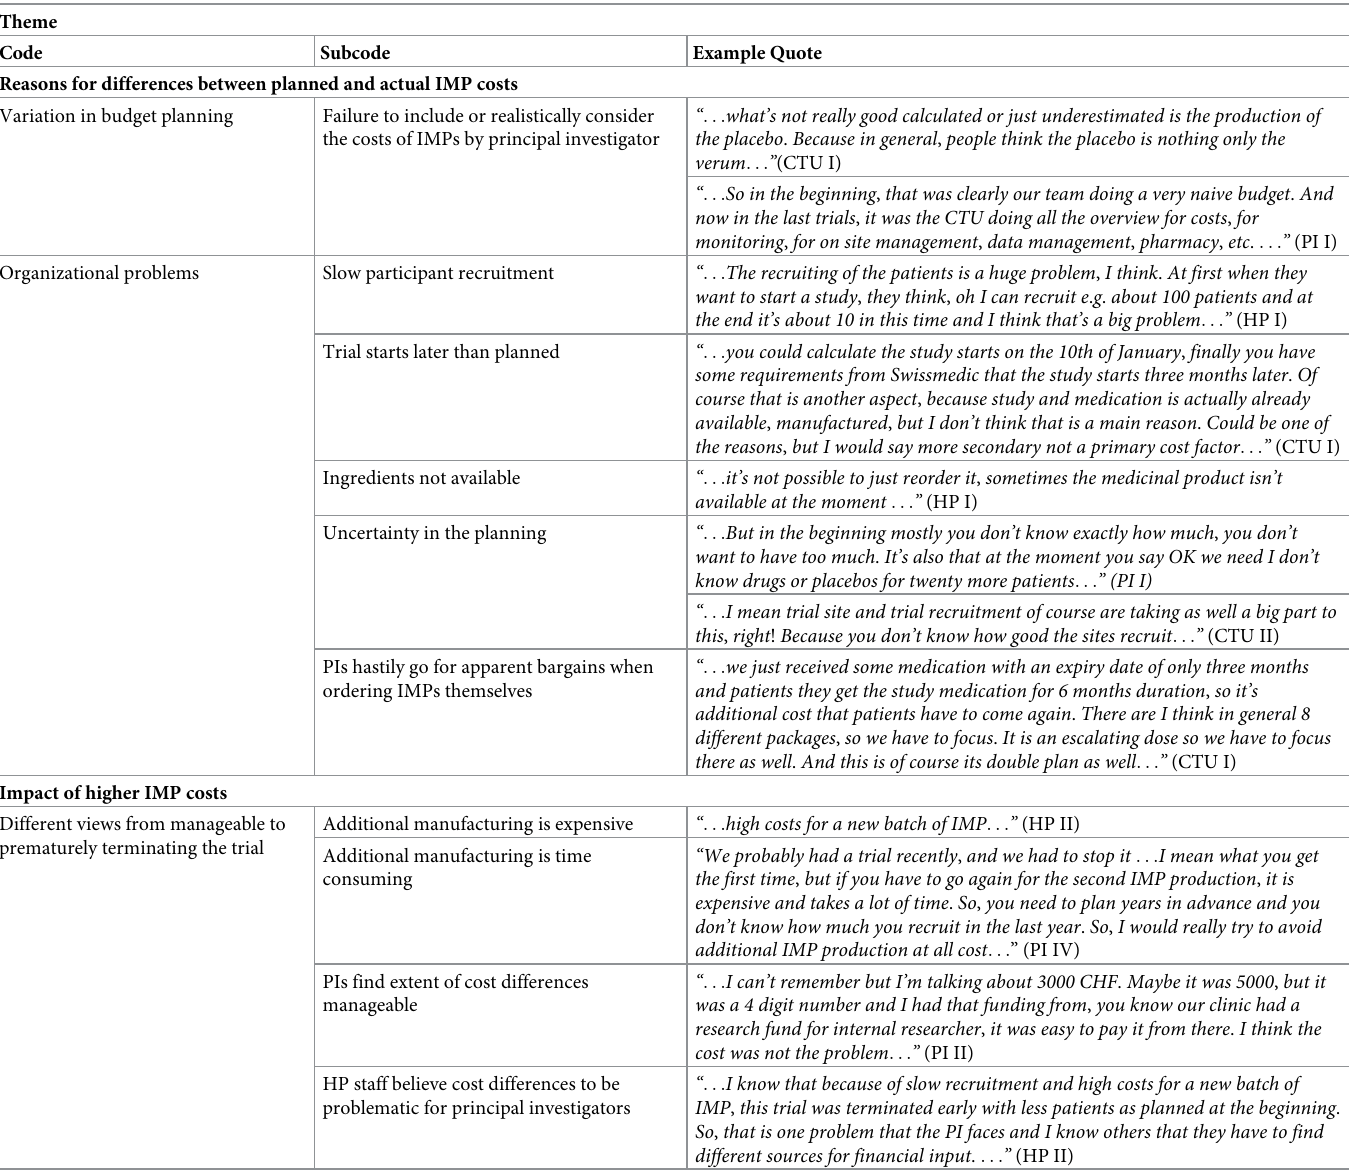
Table 4. Coding scheme regarding different aspects of IMP